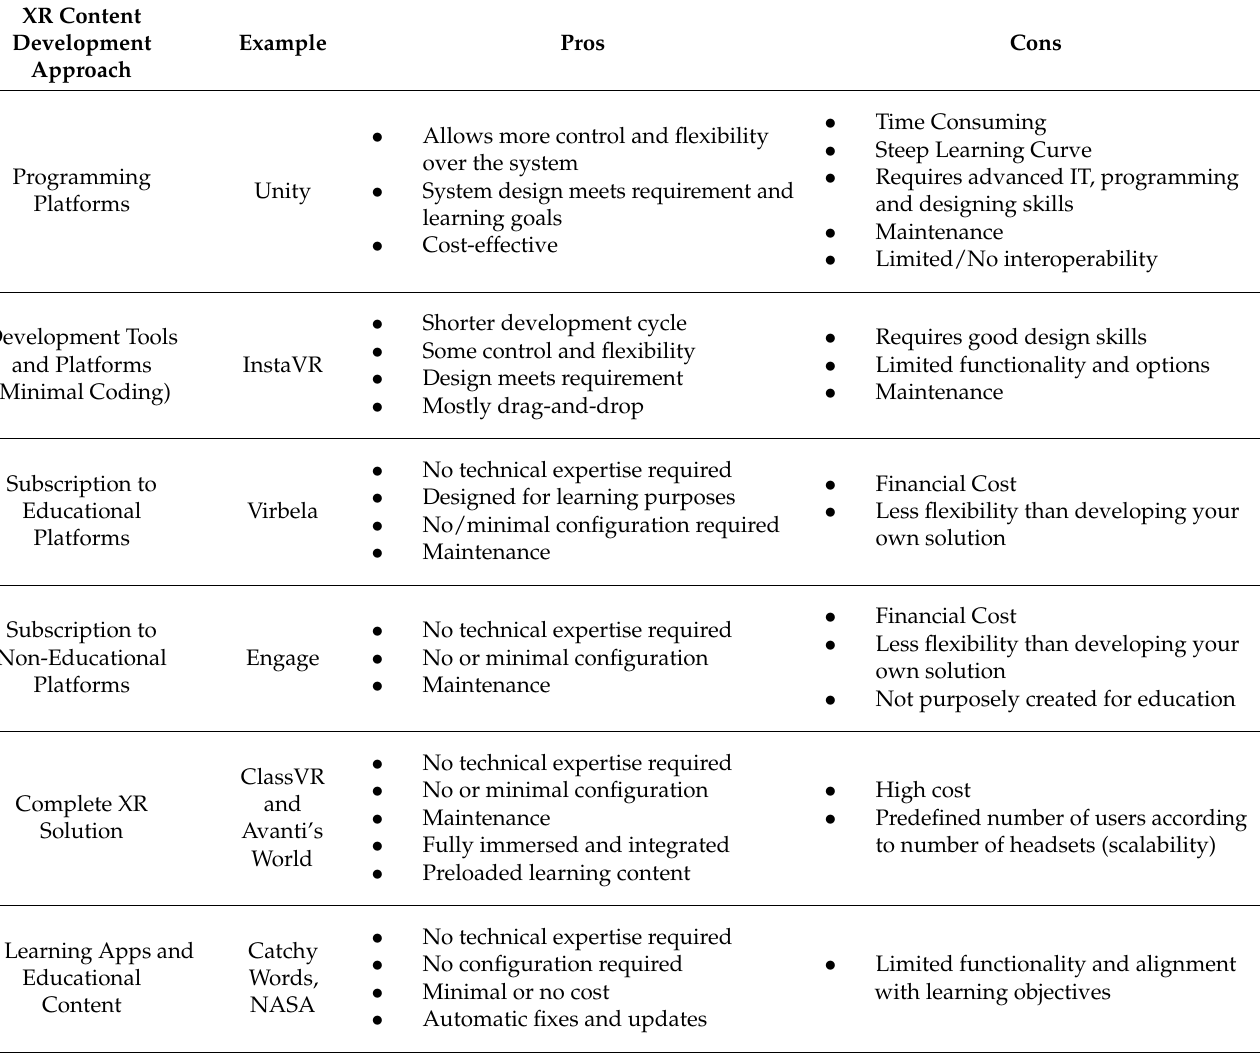
Table 1. The main advantages and disadvantages of each of XR Educational Creation